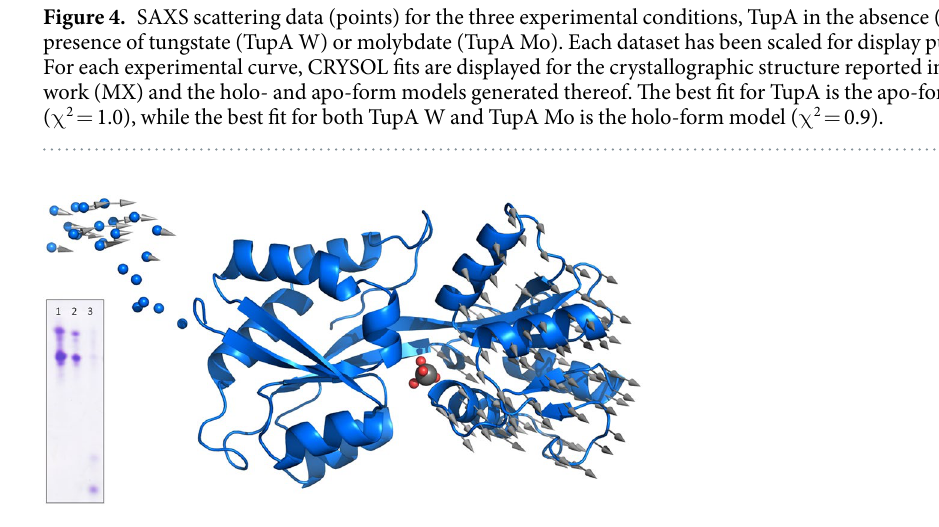
transition holo-apo is depicted by arrows. The SAXS data corroborate the hypothesis that DaG20 TupA is a flexible protein that is able to adopt a loose conformation in the free form but, when binding to molybdate or tungstate, switches to a more compact fold. This feature can be explored to design new detection systems, as discussed later. To study the impact of the metal binding in the protein stability urea-polyacrylamide gel electrophoresis was carried out for the recombinant DaG20 TupA in the presence/absence of tungstate and molybdate. TupA-ligand samples were prepared using a 10-fold excess of metal and the excess was removed by size exclusion chromatog- raphy. The gel shows that, upon tungstate binding, the wild-type protein migrates in the gel in a larger extend